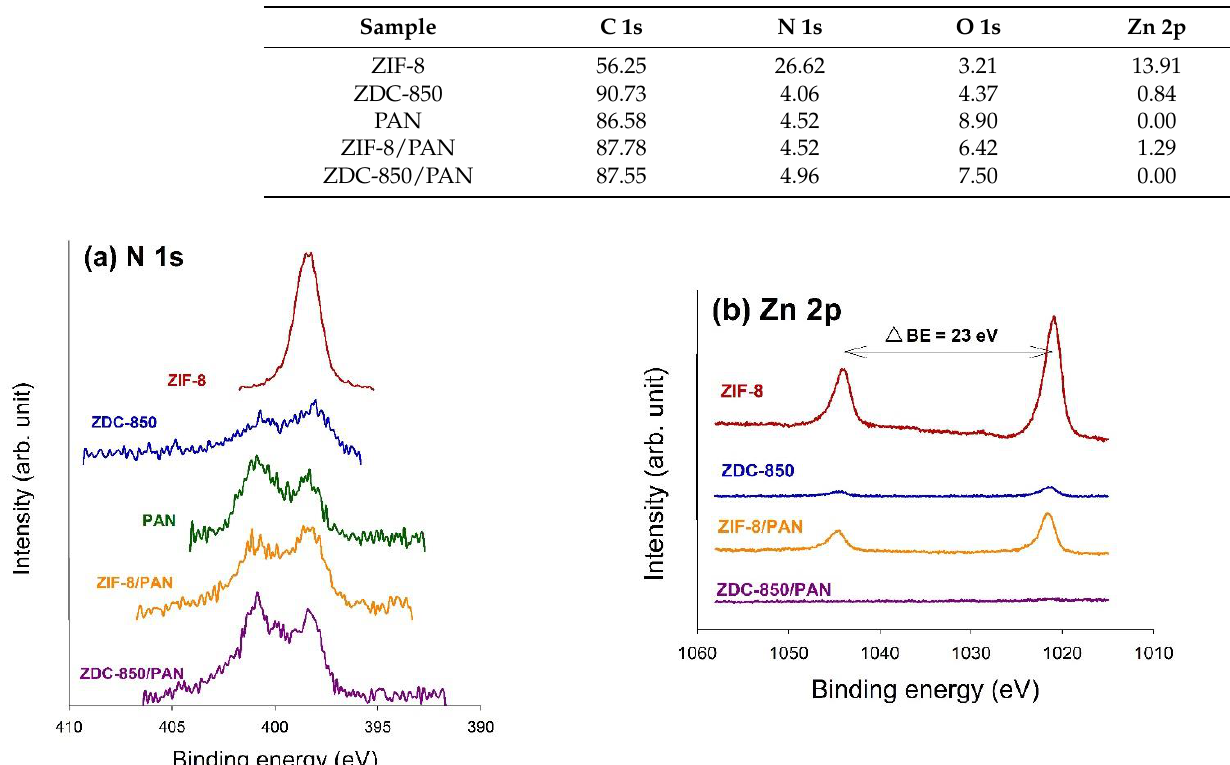
Table 2. Results of the fit of the XPS N 1s region; values given in at.% (percentage of total